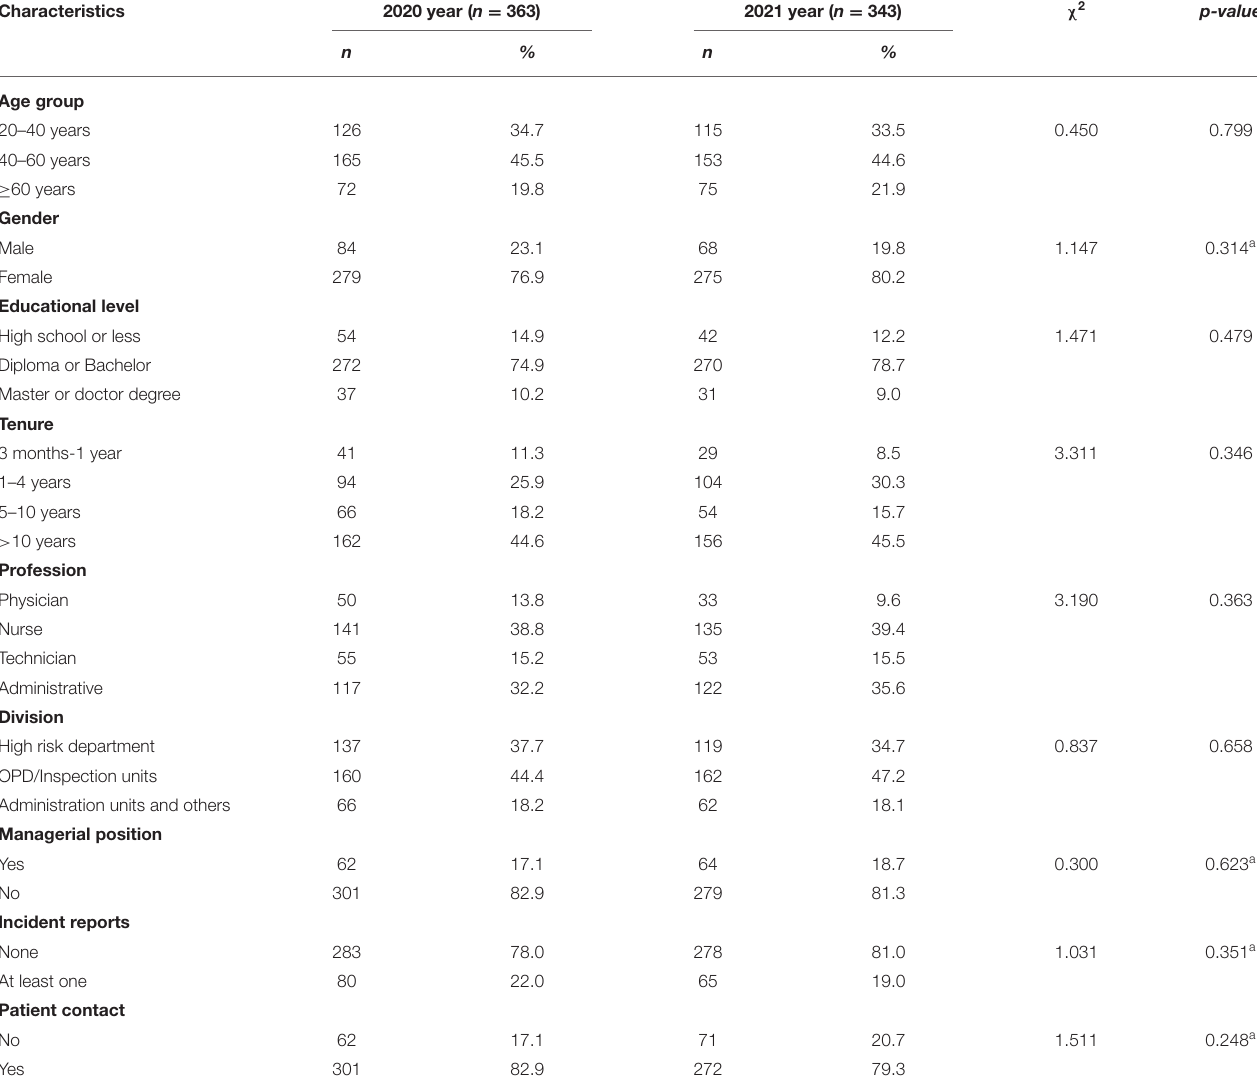
TABLE 2 | Demographic and clinical characteristics.